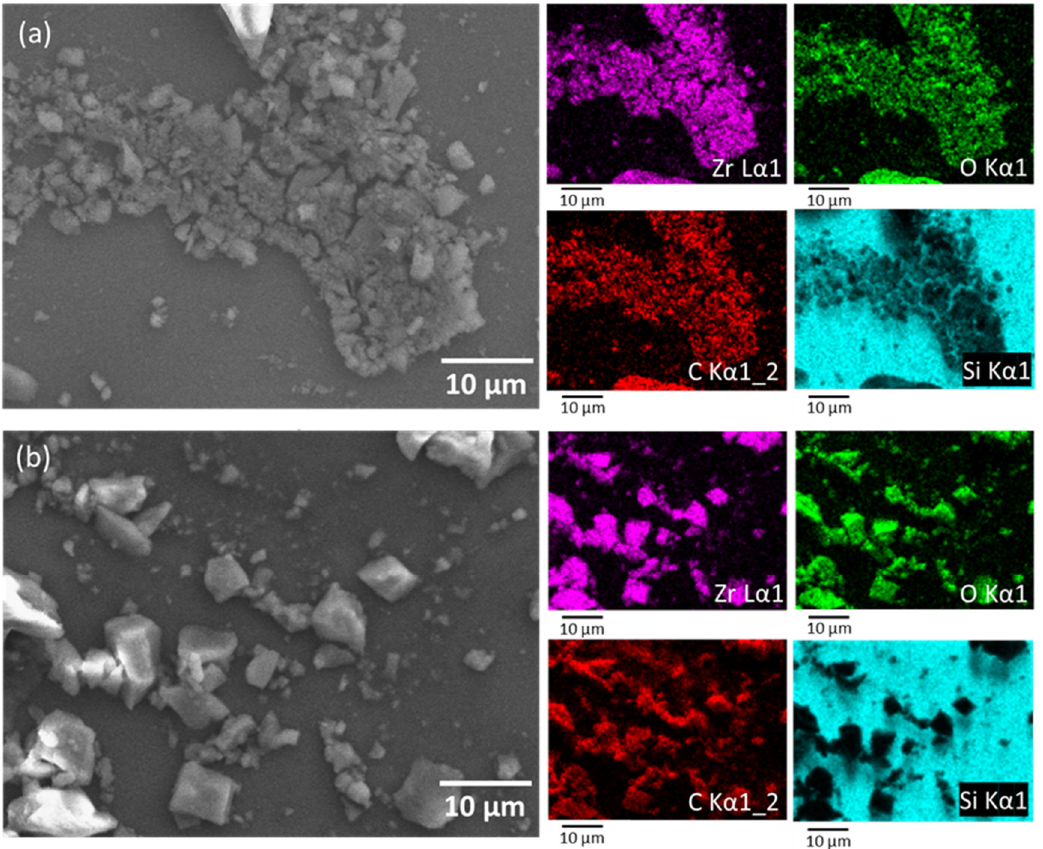
Figure 2. SEM-EDS elemental mapping images of ( a ) ZGluGO and ( b ) ZAspGO composites.